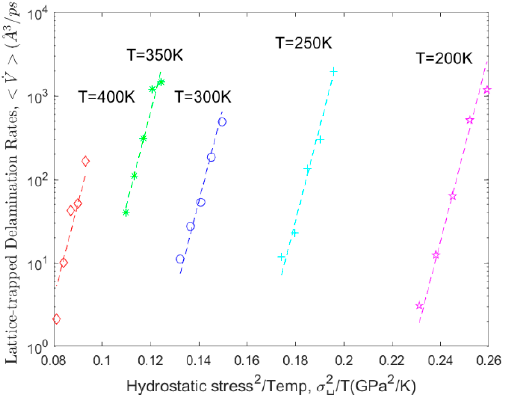
Figure 10. Lattice-trapped delamination rate data from Figure 8 plotted based on the theory of thermally activated crack growth. Dashed lines are linear fits with identical slopes.